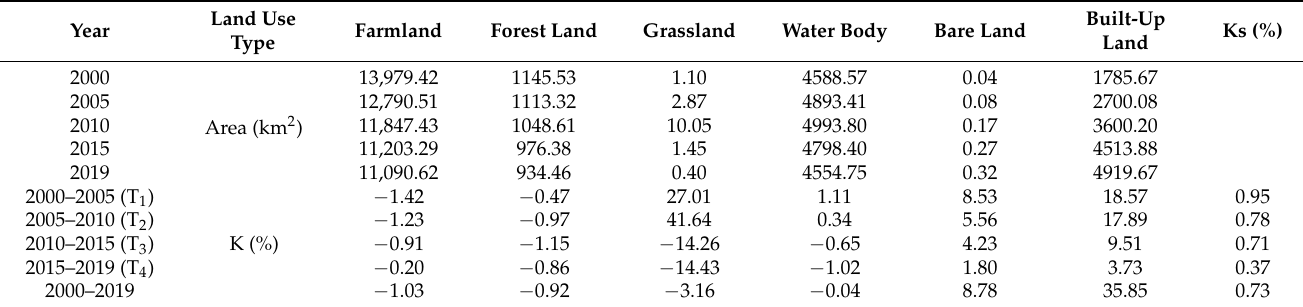
Table 2. Area and land use change dynamics in SCBJ from 2000 to